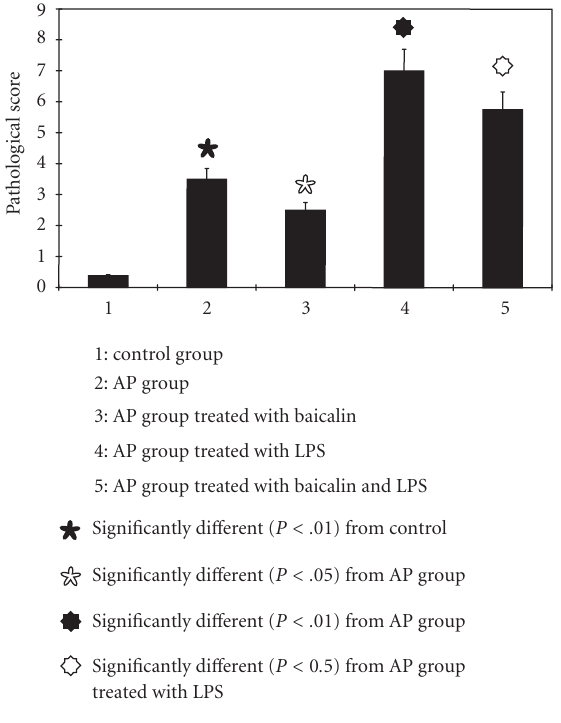
Figure 1: Pathological score of pancreatic tissue.